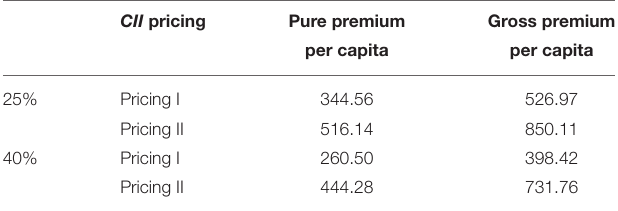
TABLE 11 | The CII pricing simulation in the ATP